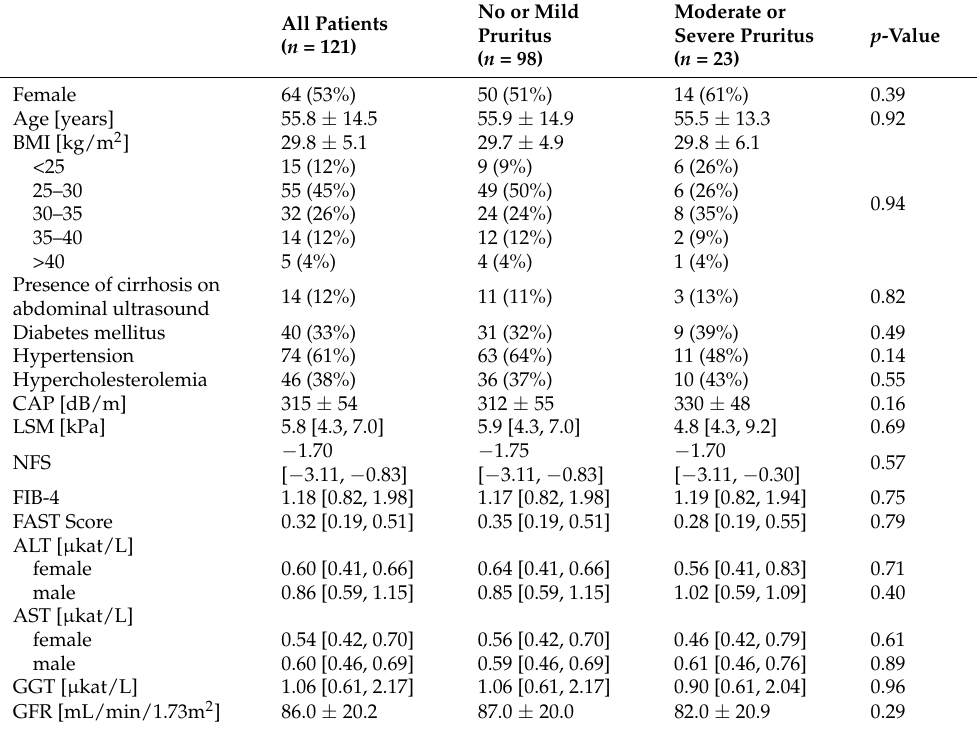
Table 3. Population characteristics for all patients, dichotomized according to pruritus severity assessed by VAS. Values are frequency (%), mean ± SD, or median [IQR]. BMI: Body mass index, CAP: Controlled attenuation parameter, FIB-4: Fibrosis 4 score, GGT: gamma-glutamyl transferase, NFS: NAFLD fibrosis score. All Patients ( n = 121)